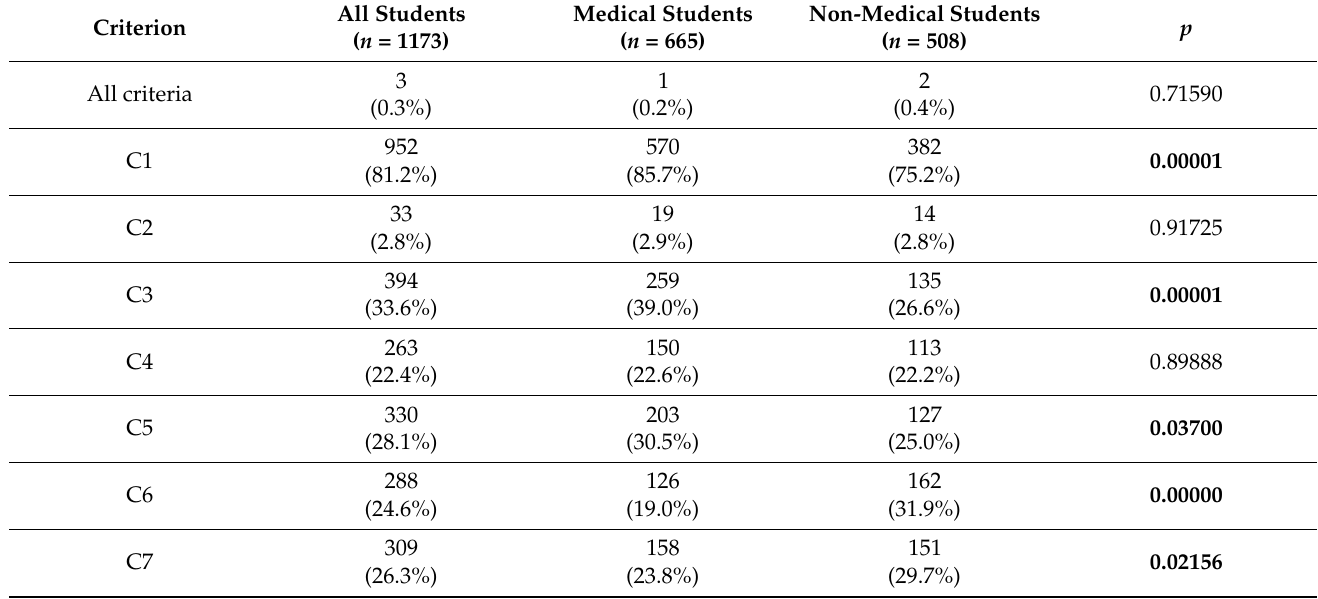
Table 3. Adherence to WHO guideline criteria concerning the correct use of face masks among